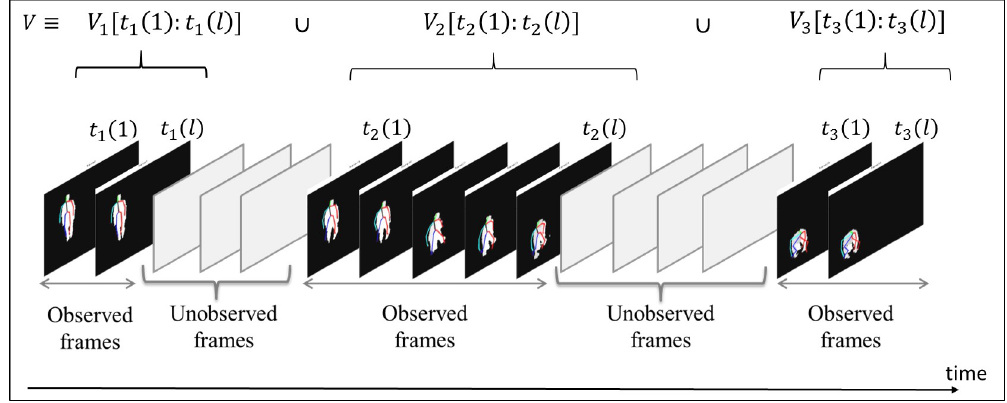
Figure 4. A partially-observed depth-map video sequence composed of three observed video